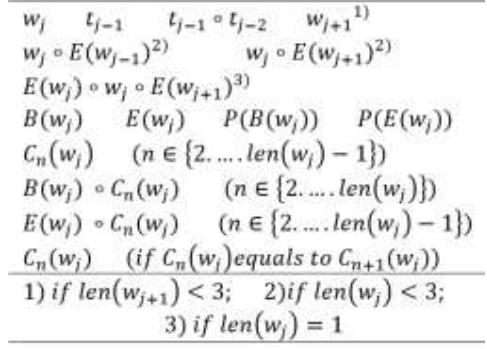
Figure 1. Feature templates for baseline POS tagger, where 𝒕 𝒊 is the tag assigned to the i-th word 𝒘 𝒊 , B(w) and E(w) is the beginning and the ending character of word w, 𝑪 𝒏 (𝒘) is the n-th character of w, P(c) is the set of tags associated with the single-character word c based on the dictionary [3].